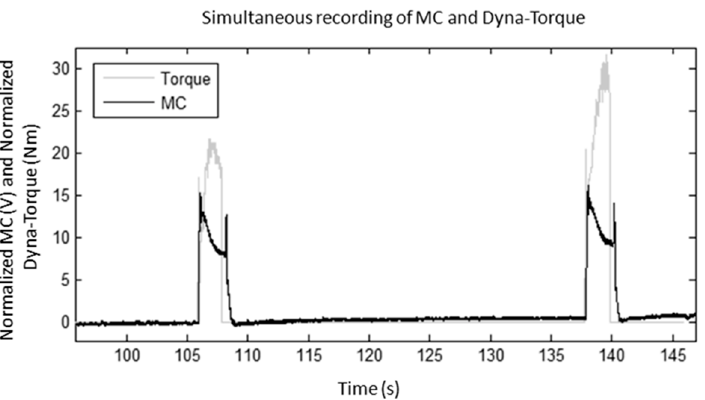
Figure 5. Normalized MC-voltage and isometric knee torque during FES-evoked contraction from one SCI